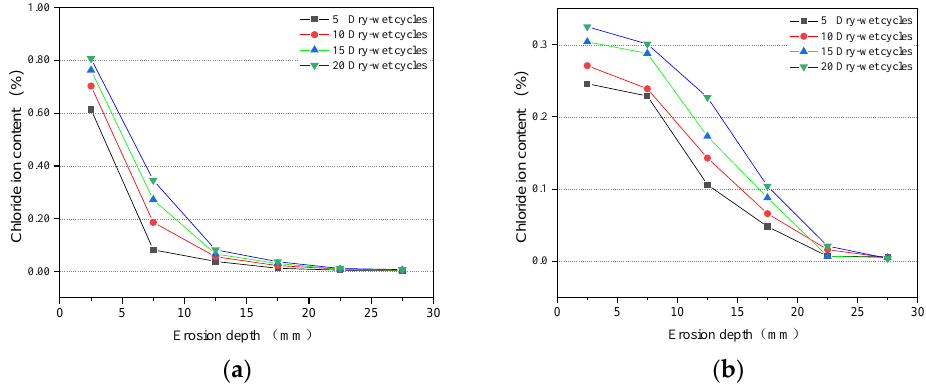
Figure 13. Chloride ion erosion distribution of SMA-ECC and MC specimens. ( a ) SMA-ECC ( b ) MC.